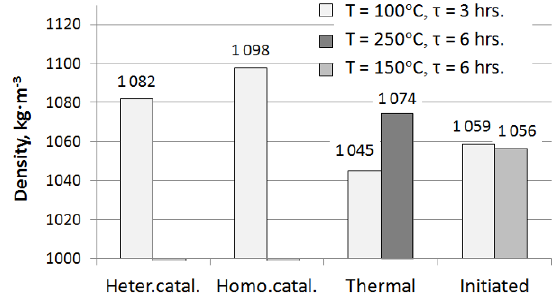
Figure 5. Density of the cooligomers synthesized by different methods.